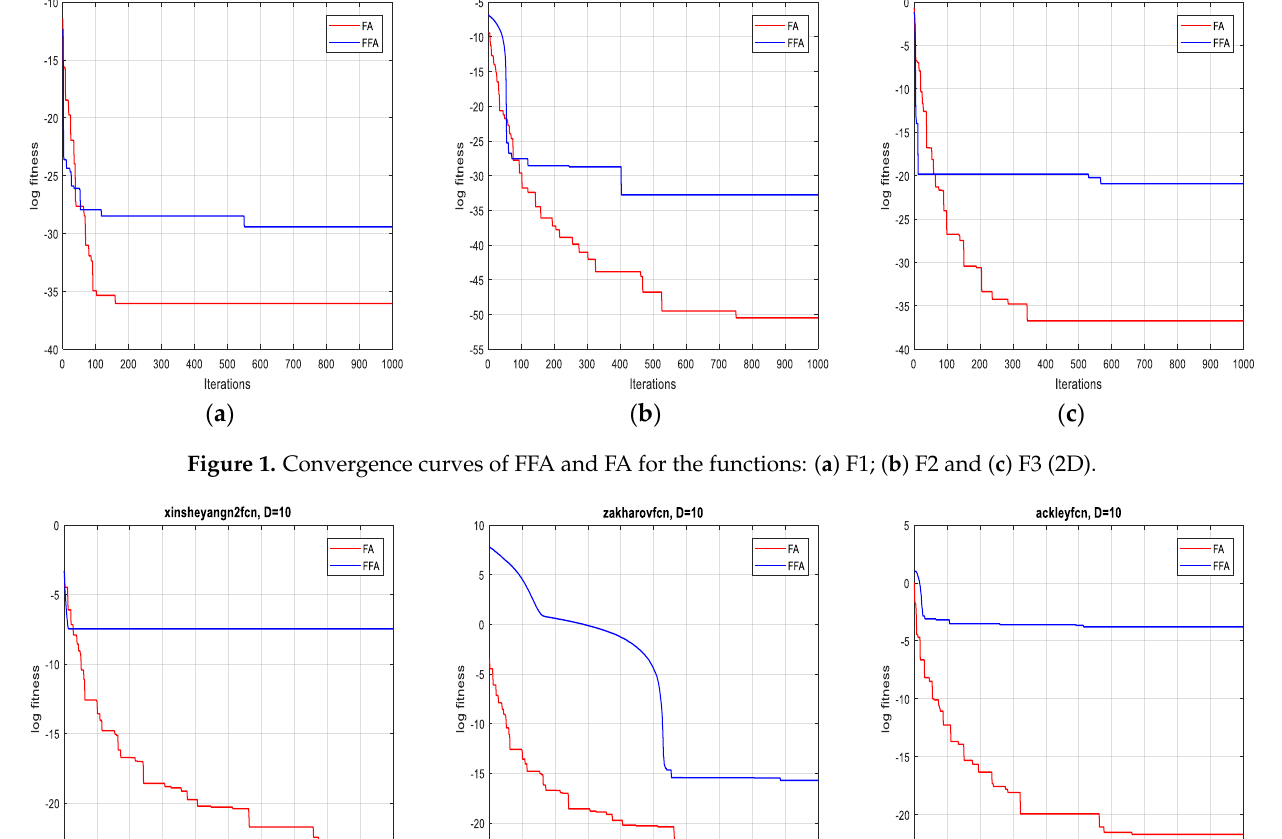
Sensors 2021 , 21 , x FOR PEER REVIEW Figure 2. Convergence curves of FFA and FA for the functions: ( a ) F4; ( b ) F5 and ( c ) F6 (10D).